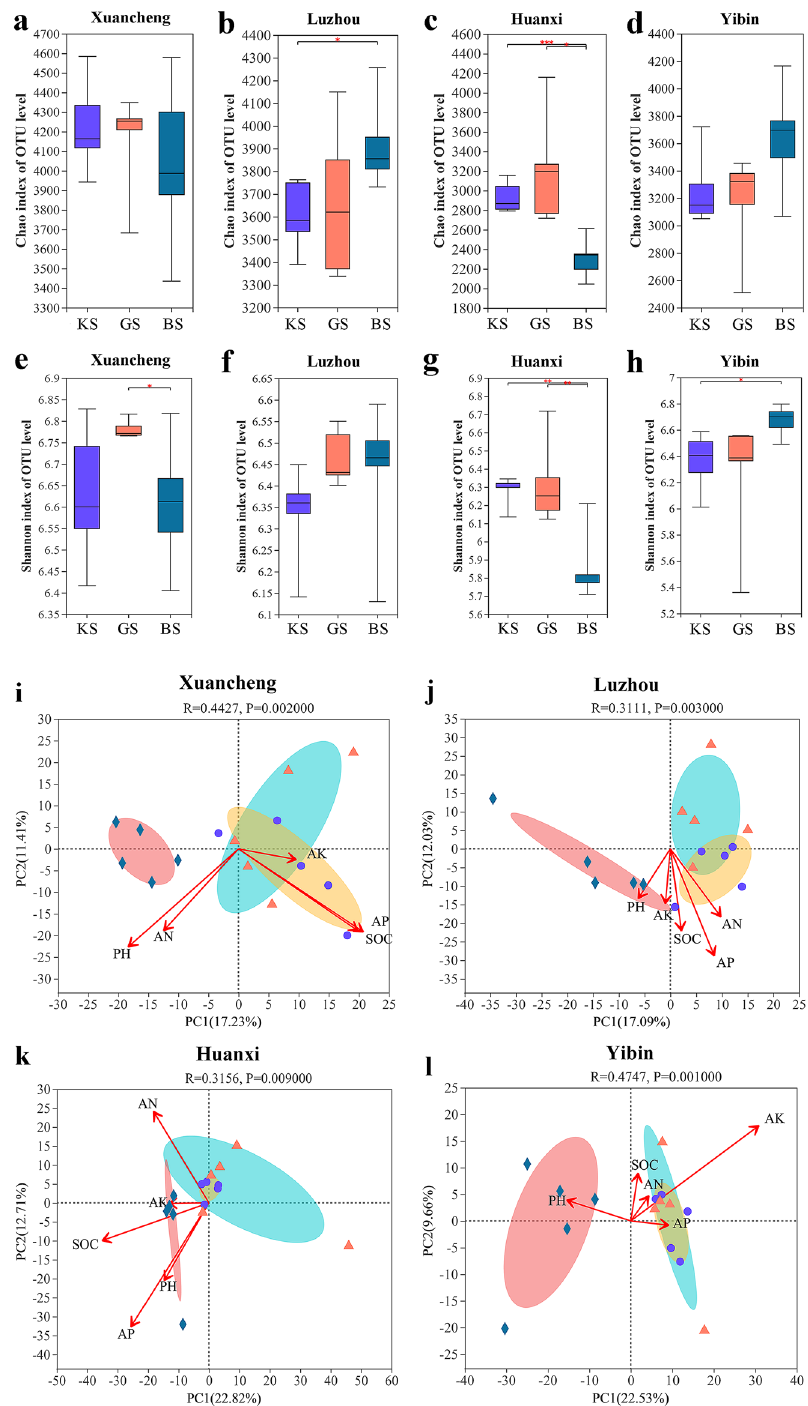
Figure 4. Alpha and PCA analysis of KS, GS and BS in Xuancheng, Luzhou, Huanxi and Yibin. ( a ) Chao1 index of OTU level for KS, GS and BS in Xuancheng. ( b ) Chao1 index of OTU level for KS, GS and BS in Luzhou. ( c ) Chao1 index of OTU level for KS, GS and BS in Huanxi. ( d ) Chao1 index of OTU level for KS, GS and BS in Yibin. ( e ) Shannon index of OTU level for KS, GS and BS in Xuancheng. ( f ) Shannon index of OTU level for KS, GS and BS in Luzhou. ( g ) Shannon index of OTU level for KS, GS and BS in Huanxi. ( h ) Shannon index of OTU level for KS, GS and BS in Yibin. ( i ) PCA of bacterial communities of KS, GS and BS in Xuancheng. ( j ) PCA of bacterial communities of KS, GS and BS in Luzhou. ( k ) PCA of bacterial communities of KS, GS and BS in Huanxi. ( l ) PCA of bacterial communities of KS, GS and BS in Yibin. The data within each group for ( a – h ) and ( i – l ) were statistically analyzed by Student’ t test and PERMANOVA, respectively (*: 0.01 < p ≤ 0.05, **: 0.001 < p ≤ 0.01, ***: p ≤